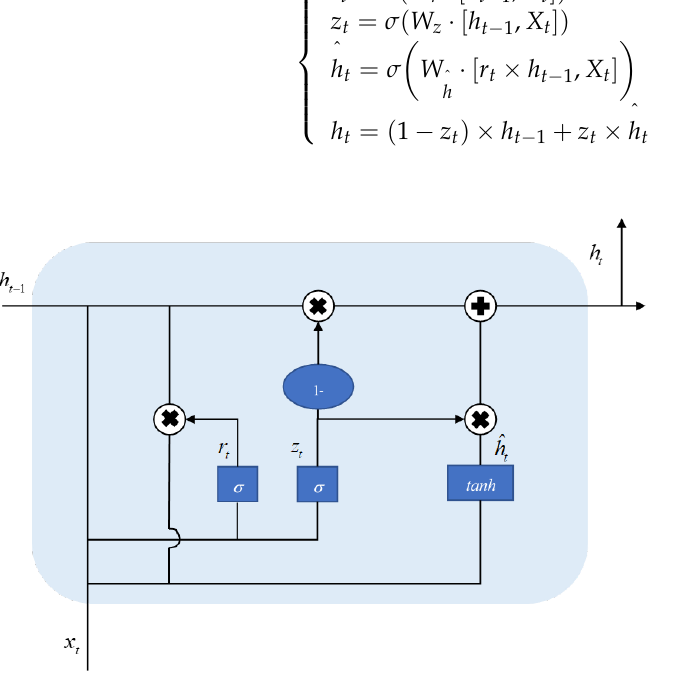
Figure 2. The GRU structure diagram. In the formula, X t , h t − 1 , z t , r t , ˆ h t , and h t , respectively, represent the input information at the current moment, the hidden state at the previous moment, the update gate, the reset gate, the candidate hidden state, and the output of the hidden layer at the current moment. W r , W z , W ˆh is the weight parameter matrix of the GRU neural network. σ is the sigmoid